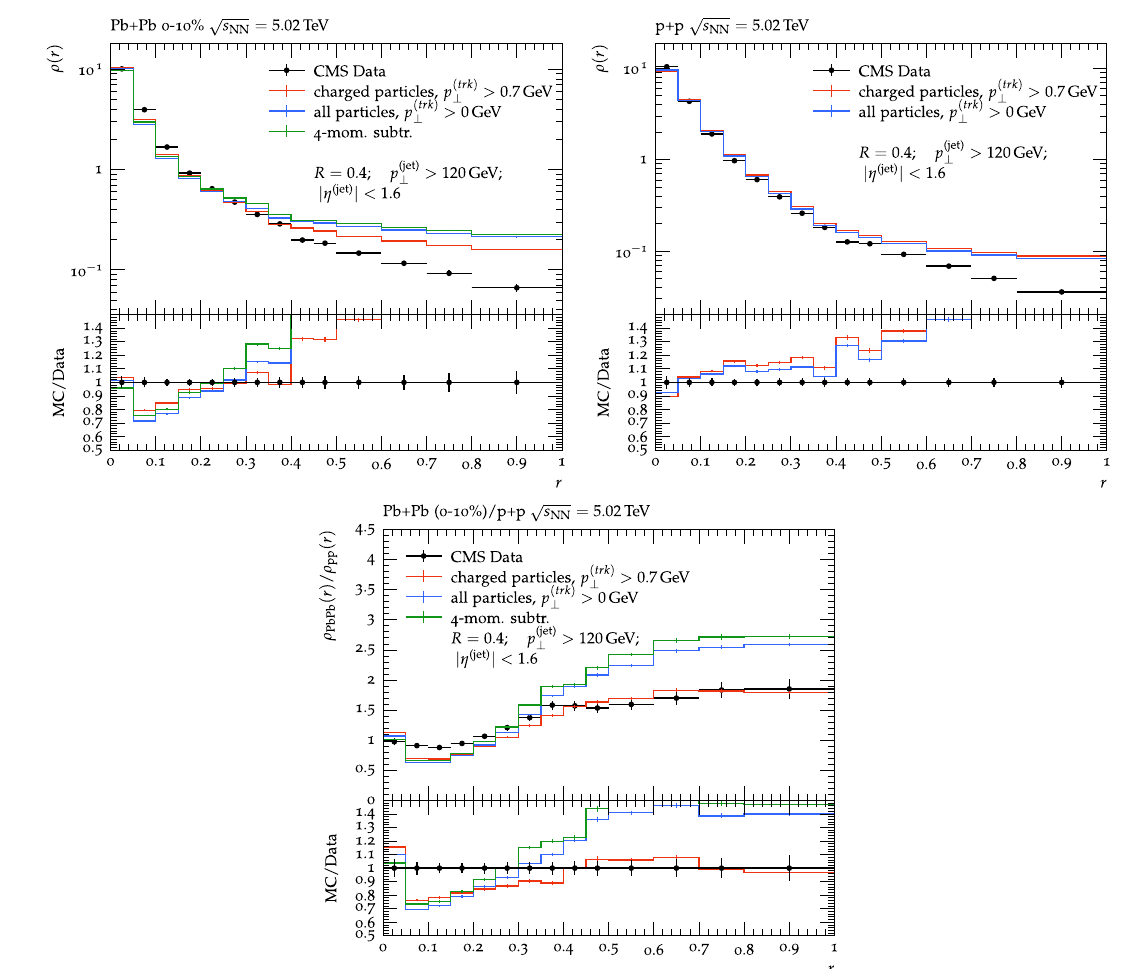
Fig. 8 Jet-hadron correlation function measured by CMS [81] at √ s NN = 5 . 02 TeV for R = 0 . 4 anti- k ⊥ jets with p and | η ( jet ) | < 1 . 6. The correlation includes only charged particles